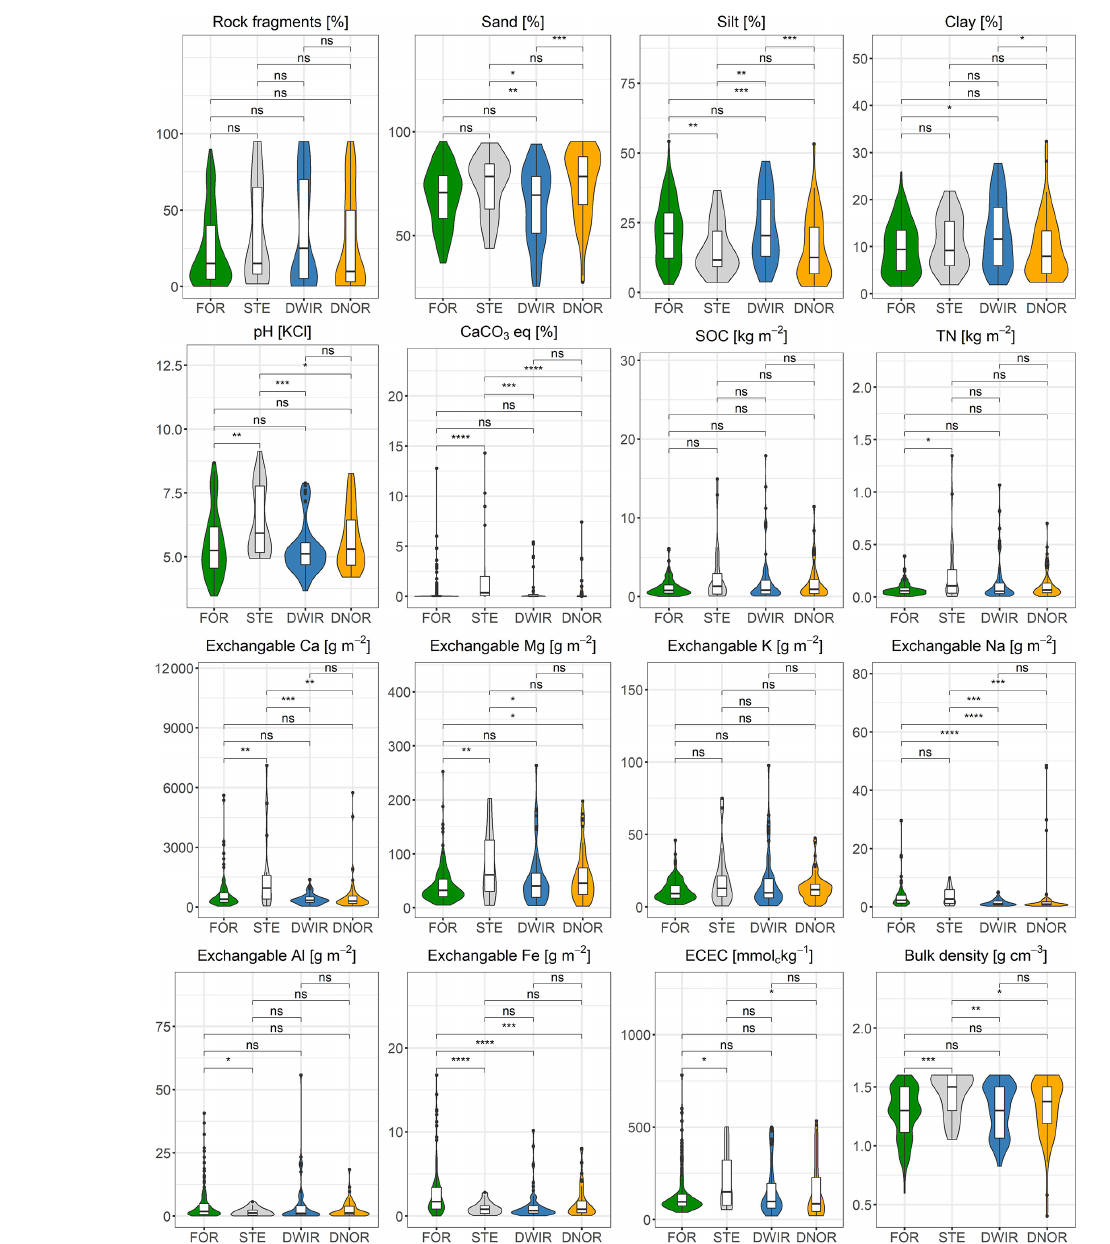
Figure 3. Properties of the entire soil profiles (down to either the bedrock or permafrost) under the following four vegetation categories ( n = 305): near-natural forest (FOR; green), steppe close to the forest (STE; grey), disturbed forest with regrowth of trees (DWIR; blue), and disturbed forest showing no regrowth of trees (DNOR; orange). P values indicated above the plots were calculated for differences between the arithmetic means (ns – p> 0 . 05; ∗ – p ≤ 0 . 05; ∗∗ – p ≤ 0 . 01; ∗∗∗ – p ≤ 0 . 001; ∗∗∗∗ – p ≤ 0 . 0001). Horizontal bars are medians, boxes are first and third quartiles, points are outliers, and violins are data